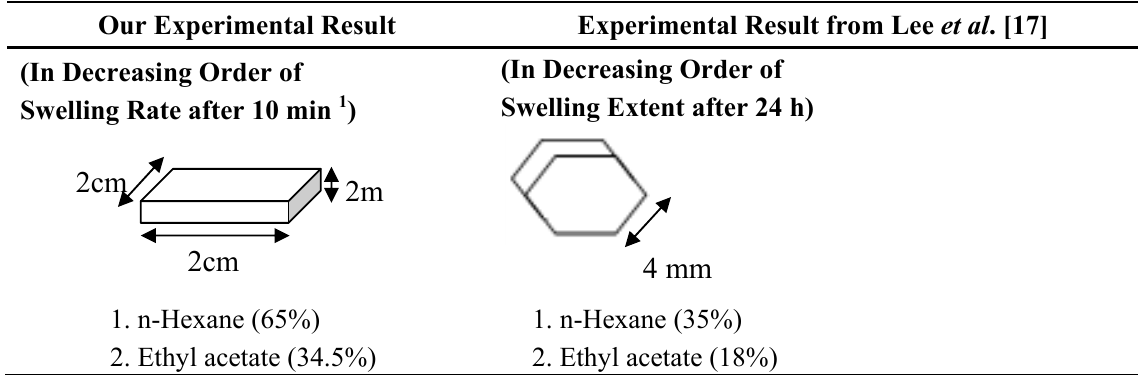
Table 1. Comparison between our experimental results (Swelling of Polydimethyl Siloxane (PDMS) 10 min after submersion in organic solvents.) with that reported by Lee et al . [17]. Both experimental data show similar trends and ranking in swelling properties. The differences in percentage of swelling are due to different measurement methods as well as to sample size and dimension. The size and dimensions of the samples are not drawn to